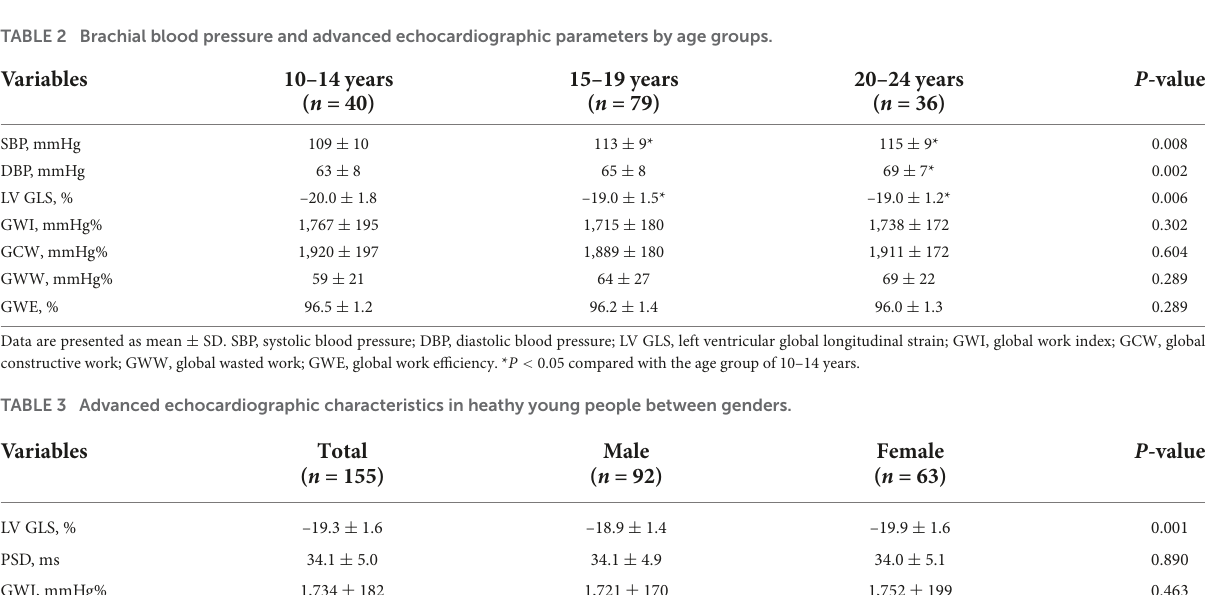
β -coefficient: 0.843 and 0.878 respectively, both P < 0.001) ( Figure 2 ), LV GLS (standardized β -coefficient: –0.777 and –0.796 respectively, both P < 0.001) ( Figure 3 ), and E/e (cid:48) (standardized β -coefficient = 0.148, P < 0.001; standardized β -coefficient = 0.099, P = 0.002, respectively). Moreover, both GWW and GWE significantly correlated with PSD (standardized β -coefficient = 0.250, P = 0.002; standardized β - coefficient = − 0.208, P = 0.007, respectively) ( Figure 4 ) and E/A (standardized β -coefficient = − 0.165, P = 0.038; standardized β -coefficient = 0.162, P = 0.036, respectively). GWE was also found to be inversely correlated with LV GLS (standardized β -coefficient = − 0.306, P < 0.001), while GWW was not associated with SBP and GLS. There were no associations between any of GMW indices with age, BSA, LVMI and LVEF on multivariate analysis. Noticeably, the β - standardized coefficients from multivariate linear regression model revealed that GWI and GCW were more closely correlated with SBP than LV GLS.